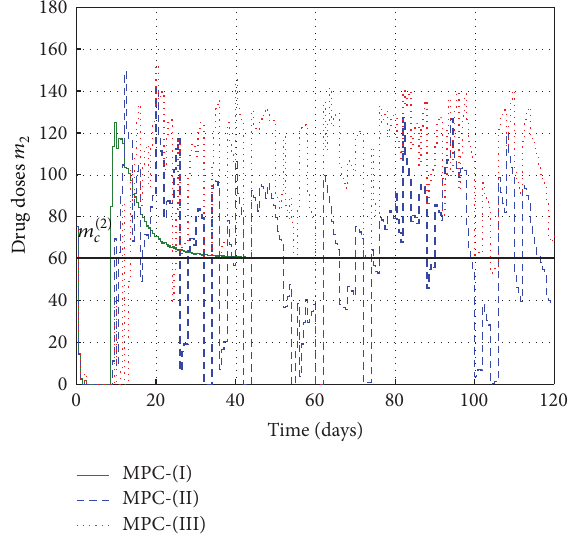
Figure 8: The drug dose of the second type designed by